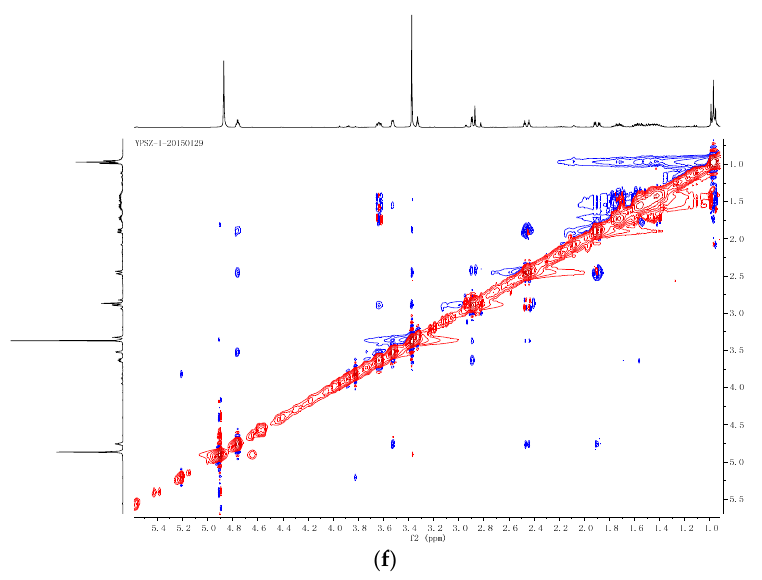
Figure 3. Supporting information of compound 1 . ( a ) 1 H-NMR of compound 1 ; ( b ) 13 C-NMR and DEPT (Distortionless Enhancement by Polarization Transfer) of compound 1 ; ( c ) HSQC (Heteronuclear Multiple-Quantum Correlation) of compound 1 ; ( d ) 1 H- 1 H COSY (correlated spectroscopy) of compound 1 ; ( e ) HMBC (Heteronuclear Multiple Bond Correlation) of compound 1 ; ( f ) NOESY of compound 1 .